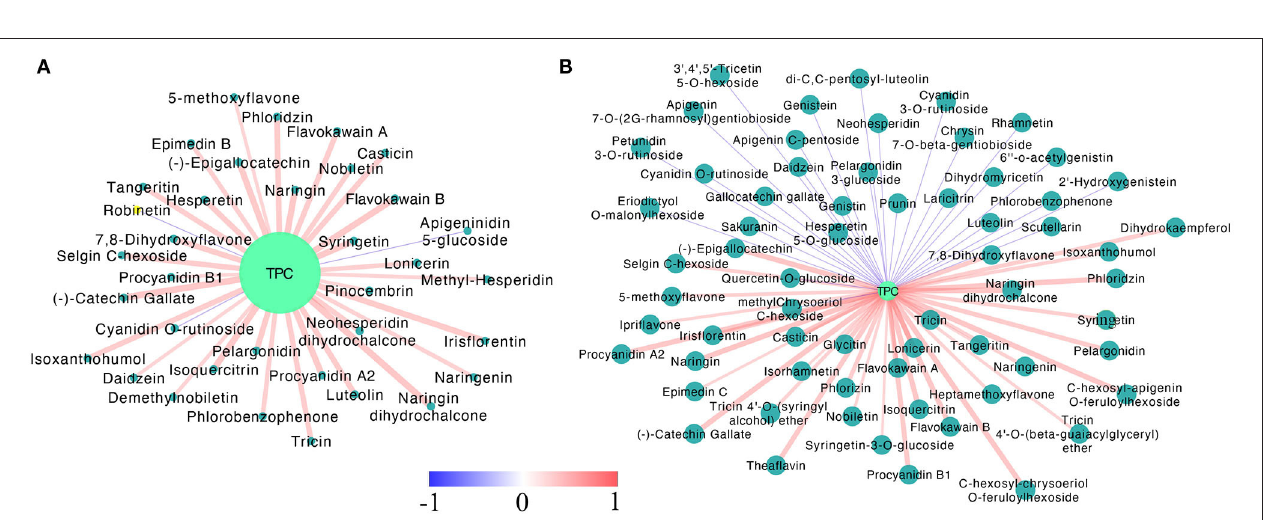
FIGURE 4 | The Pearson correlation analysis of differentially accumulated flavonoids and total phenolic contents in MT (A) and WT (B) fruits during fruit development and ripening. Only the pairwise with p -values ≤ 0.05 were showed. The dark and light blue circles indicated differentially accumulated flavonoids and the total phenolic content, respectively. The red and blue lines suggested positive and negative correlation, color scale, and the line width indicated the coefficient value, the wider the line, the larger the r value.